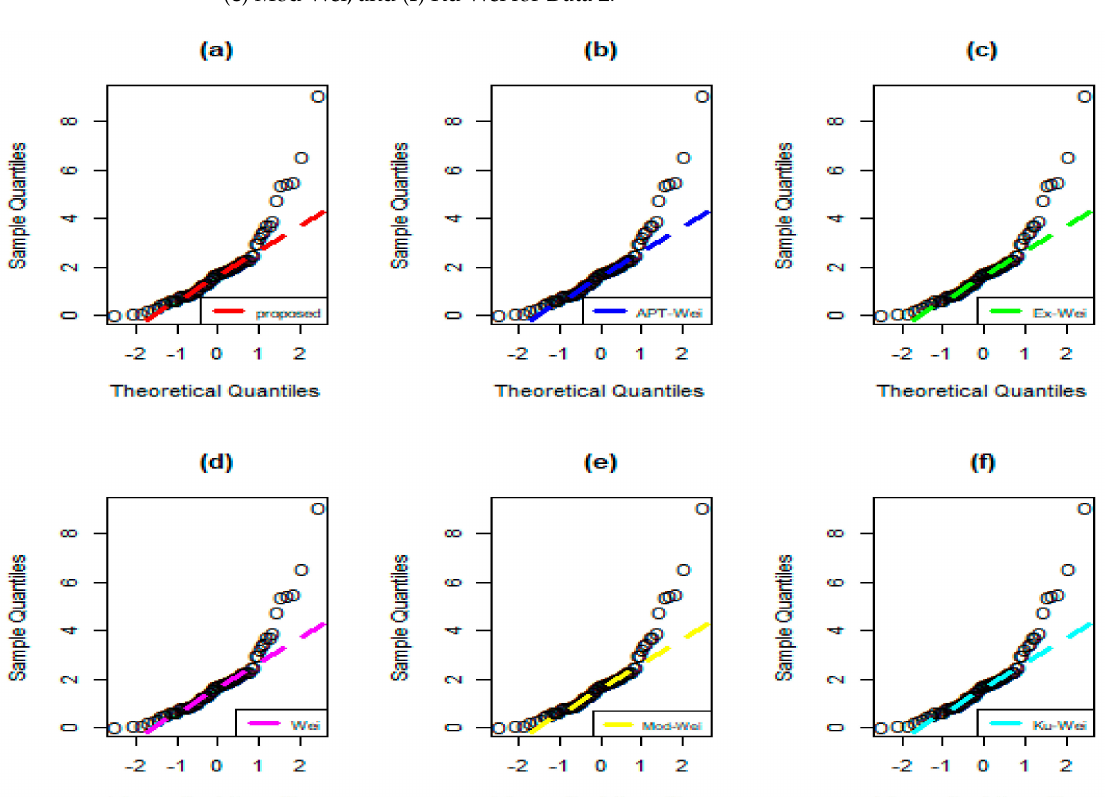
Figure 18. Q-Q (quantile–quantile) plots of ( a ) NMEPA-Wei, ( b ) APT-Wei, ( c ) Ex-Wei, ( d ) Wei, ( e ) Mod-Wei, and ( f ) Ku-Wei distributions for Data